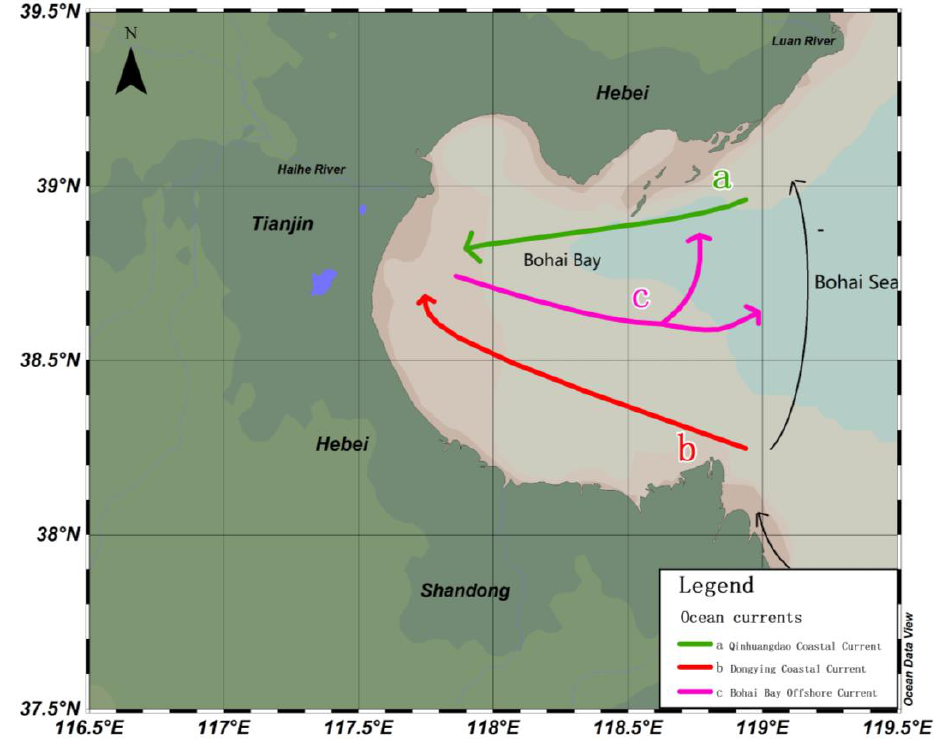
Figure 2. The Characterization of the ocean currents in the study area [26]. Note: The map is a repaint. The scale is 1:2,200,000. This image was created with Ocean Data View (ODV) software, version 5.3.0 (Alfred Wegener Institute, Bremerhaven, Germany).